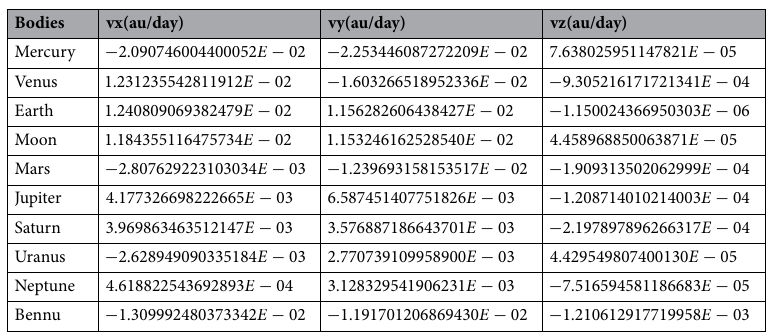
Table 2. Input values for the velocity of each body as of August 5, 2021. Data taken from JPL NASA.